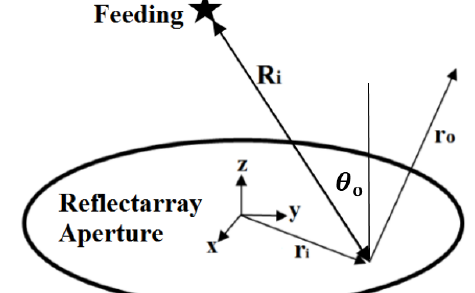
Figure 1: Reflection from a general point on a reflectarray aperture.